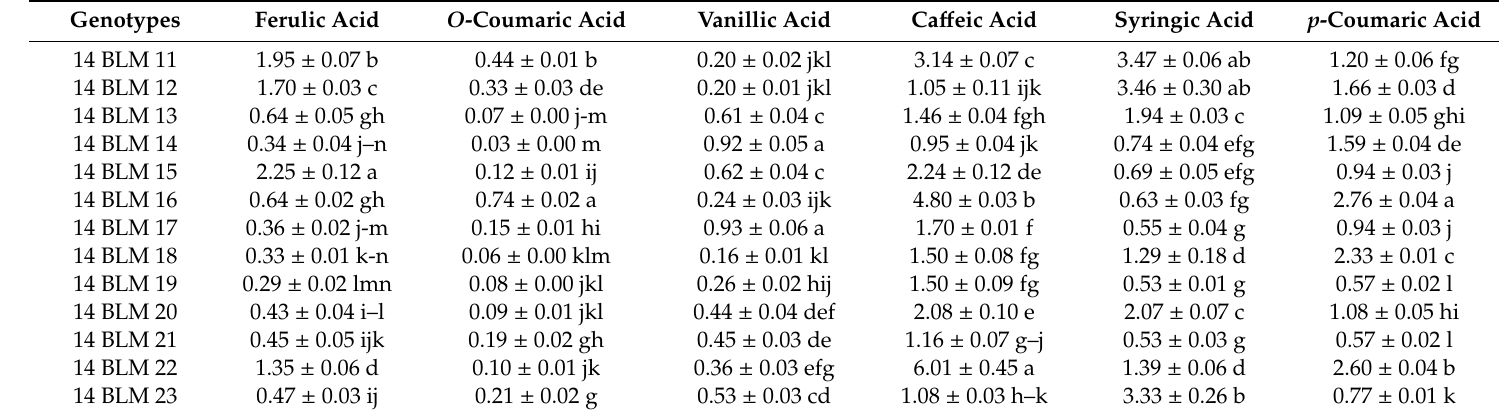
* : Di ff erent letters in columns indicate significantly di ff erent values at p ≤